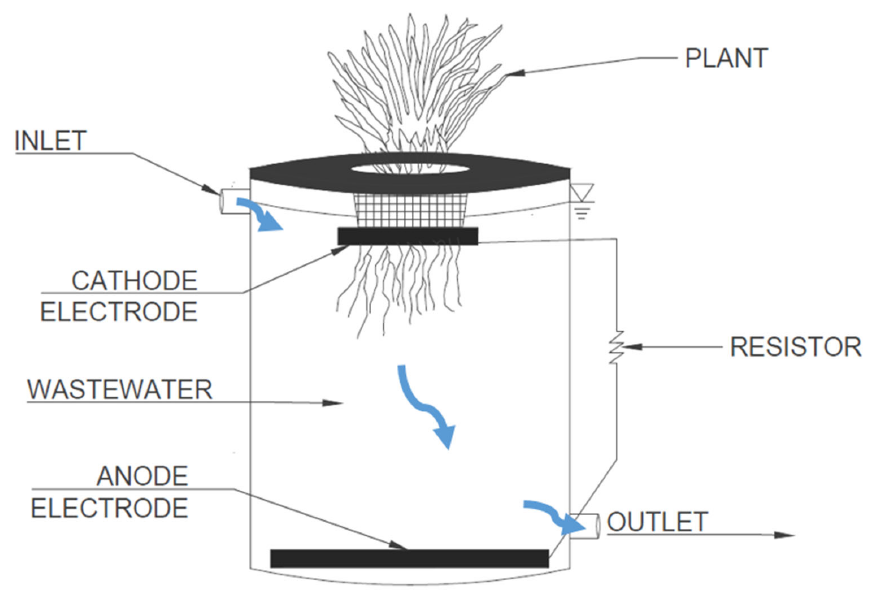
Figure 2. Representation of the Hyp ‐ MFC system for nonedible plants with major components.